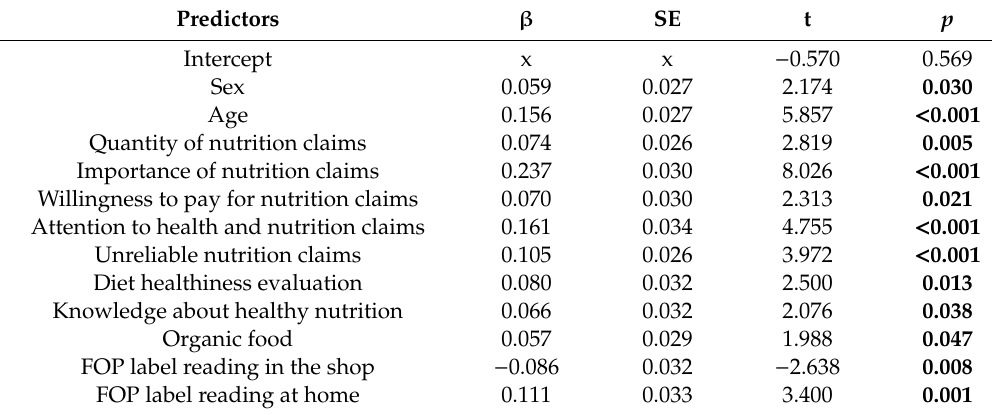
Table 6. Selected predictors of the importance attached to salt content information on food packaging (the final multiple regression